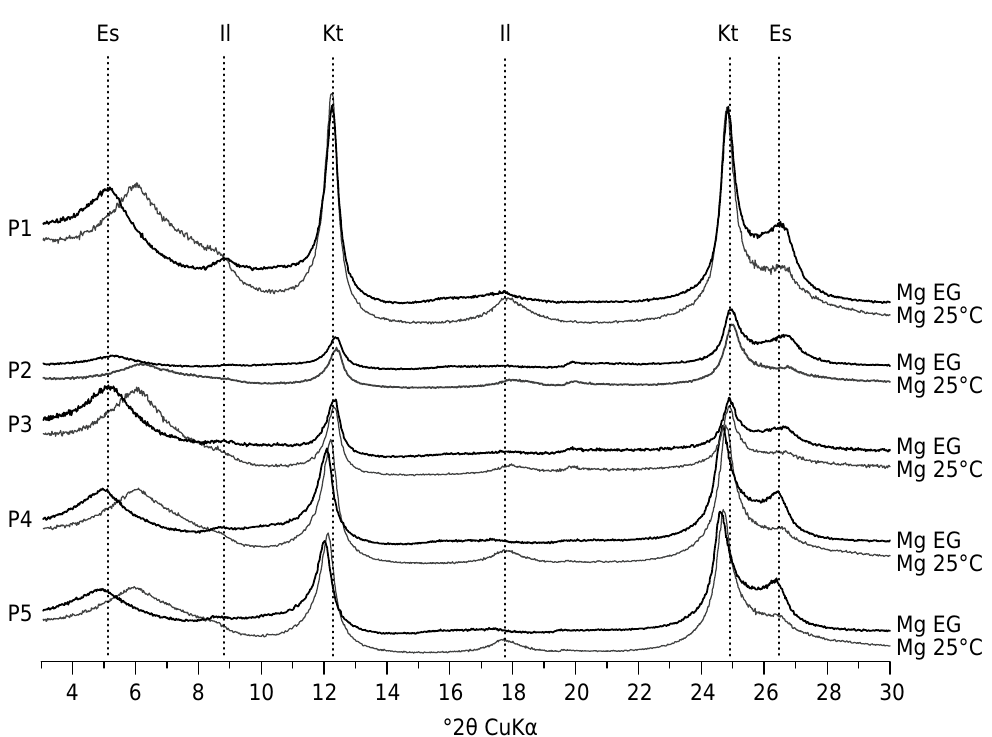
Figure 5. Diffractograms of the fine clay samples of the B horizons, saturated with Mg (Mg 25 °C) and solvated with ethylene glycol (Mg EG). In all profiles (P1, P2, P3, P4, and P5), there is the presence of crystallinity of kaolinite (Kt) in a greater degree, followed by 2:1 clay minerals, such as smectite (Es) and illite (Il).